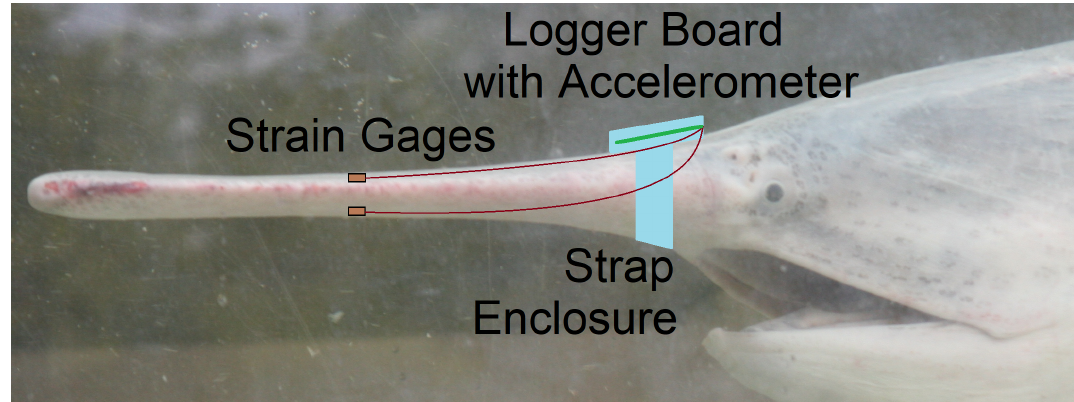
Figure 1. Proposed placement of instruments on the rostrum of a Paddlefish for future in vivo experiments. This is the same configuration used for the proof-of-concept experiment with an amputated rostrum described in this